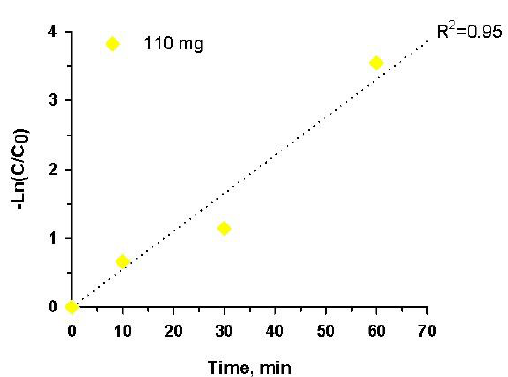
Fig. 14. Influence of IPA, TEA, and p-BQ scavengers on MB photocatalytic degradation over Fe-ZIF-8 nanocatalyst in optimum operating conditions.